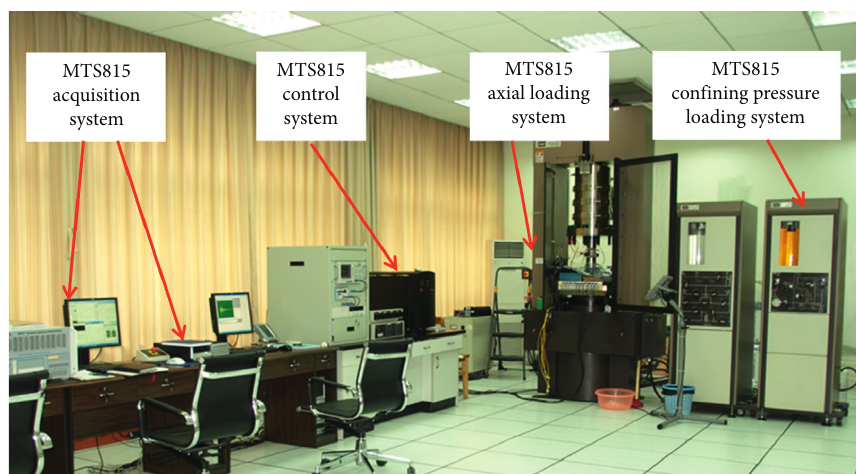
Figure 1: Rock mechanics experimental system of MTS815. Table 1: Direct tensile test results of Beishan granite samples. Sample